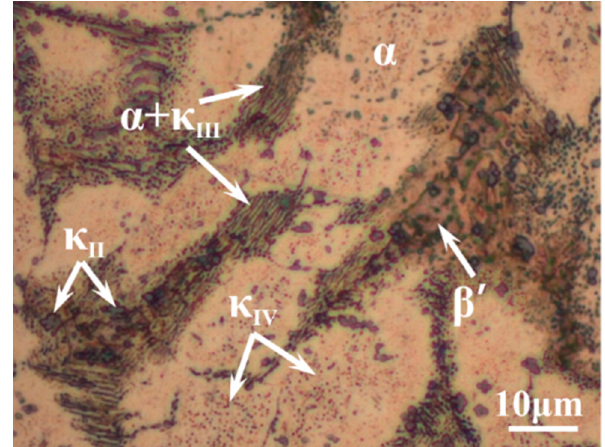
Figure 1. Optical micrograph of the microstructure of NAB alloy.